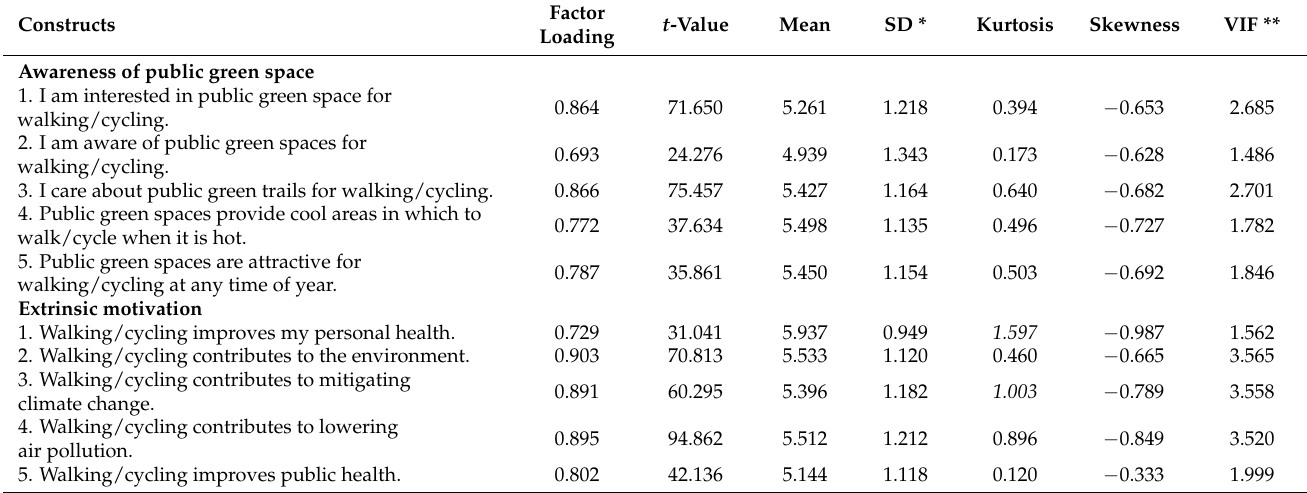
Table 2. CFA on the measurements, descriptive statistics, and normal